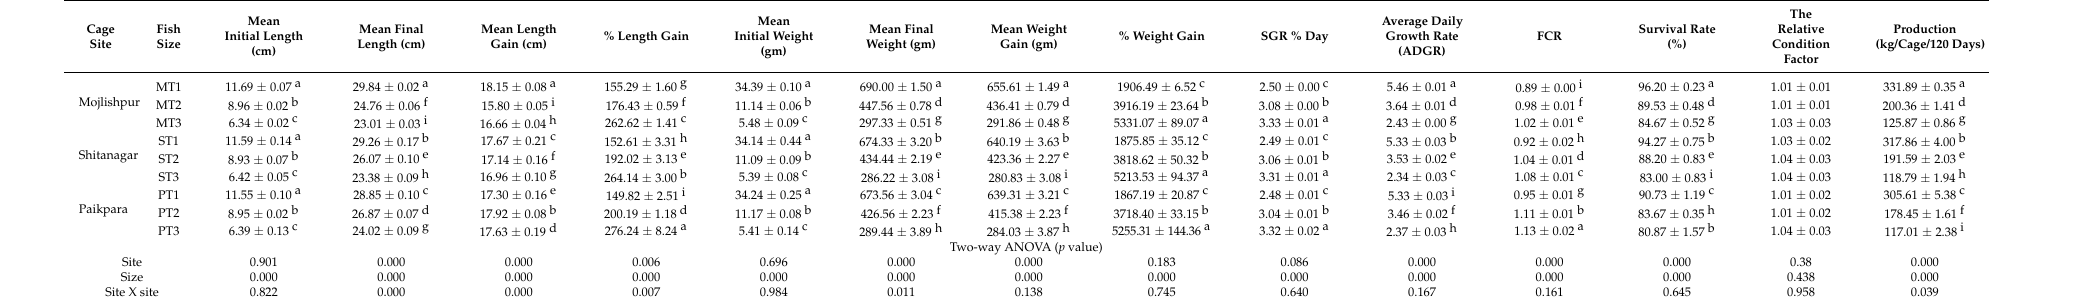
Table 4. Growth parameters of Nile Tilapia ( Oreochromis niloticus L.) under cage-culture system in Titas River of Bangladesh with different stocking densities in the second cycle